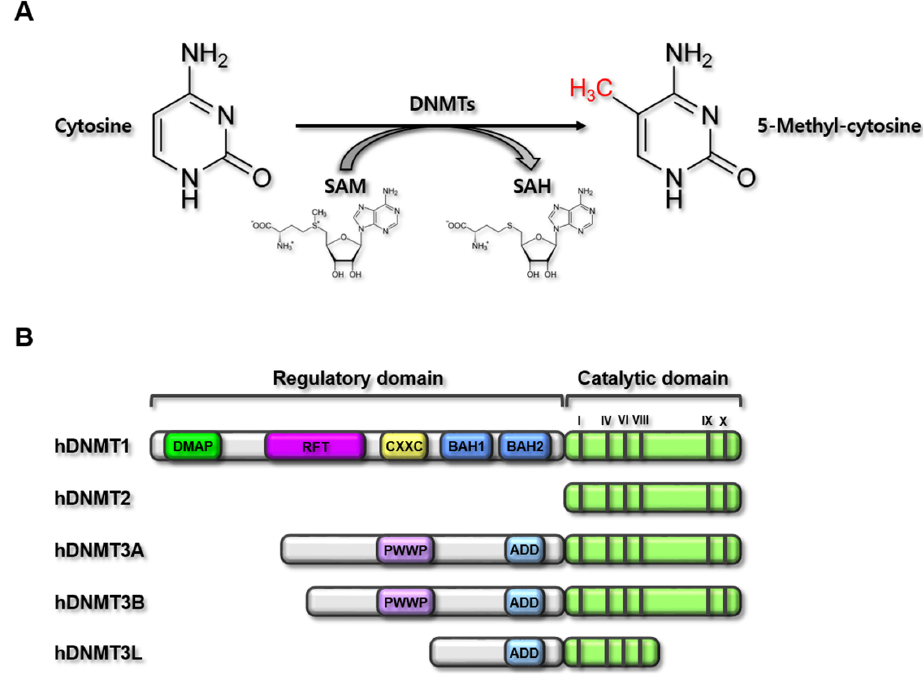
Figure 2. DNMT ‐ mediated methylation reaction and domain structure of human DNMTs. ( A ) Chemical reaction of DNMT ‐ mediated methylation. DNMTs catalyze the methylation at cytosines of CpG in the gene promoter regions by transferring methyl groups from methyl donor, SAM, producing 5-methyl-cytosine in the gene promoter regions and SAH. ( B ) Domain structures of human DNMT (hDNMT) family members. hDNMTs consist of five members; hDNMT1 (1616 amino acids), hDNMT2 (391 amino acids), hDNMT3A (912 amino acids), hDNMT3B (853 amino acids), and hDNMT3L (386 amino acids). hDNMTs have two main domains; the regulatory and catalytic domains. The catalytic domain is conserved in all hDNMTs. hDNMT1 is the longest member with DMAP, RFTD, CXXC, and two BAHs in the regulatory domain. hDNMT2 is the smallest member existing only catalytic domain. hDNMT3A and hDNMT3B have PWWP and ADD in the regulatory domain in common, but hDNMT3B is little bit smaller than hDNMT3A. hDNMT3L has only ADD in the regulatory domain with the shorter catalytic domain. Bars in the catalytic domain (I, IV, VI, VIII, IX, and X) represent the catalytic active sites. SAM, S-adenosyl- L -methionine ; SAH, S-adenosyl- L -homocysteine ; DNMT, DNA methyltransferase; DMAP, DNA methyltransferase-associated protein 1-interacting domain; RFT, replication foci targeting sequence domain; CXXC, CXXC domain; BAH, bromo-adjacent homology domain; PWWP, PWWP domain; ADD, ATRX-DNMT3-DNMT3L